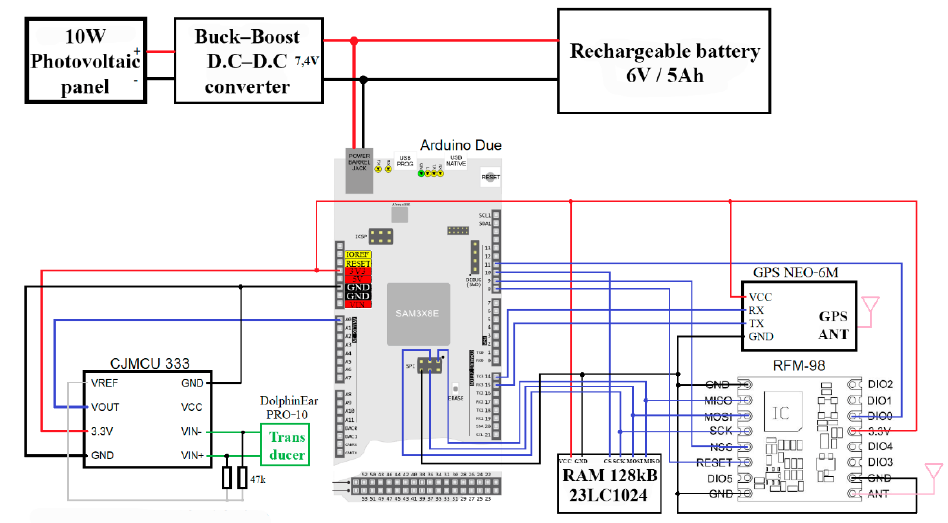
Figure 3. Electrical diagram of a beacon.